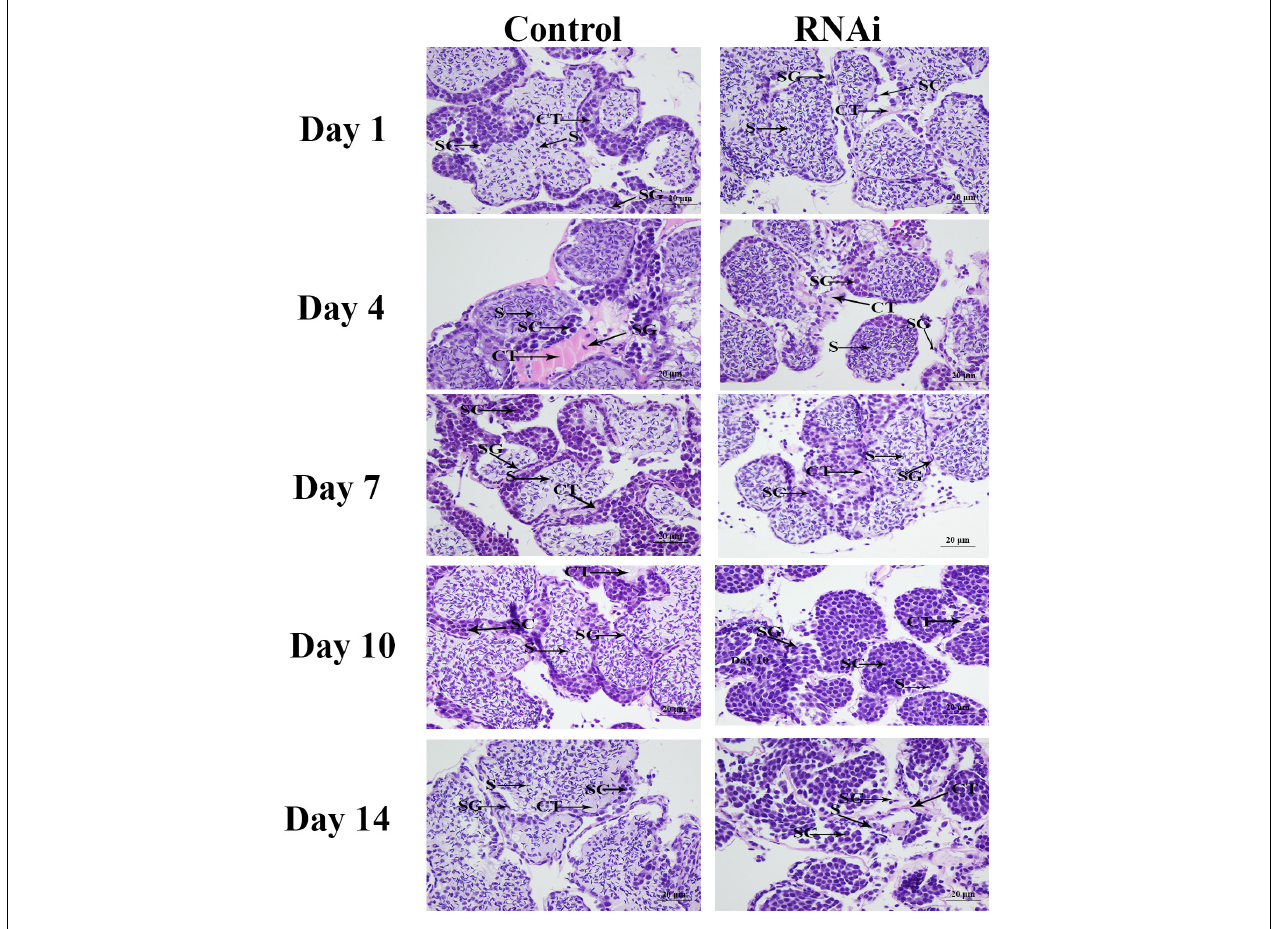
FIGURE 9 | The histological observations of testis between RNAi and control group. SG, Spermatogonia; SC, spermatocyte; S, sperm; CT, collecting tissue. Scale bars = 20 µ